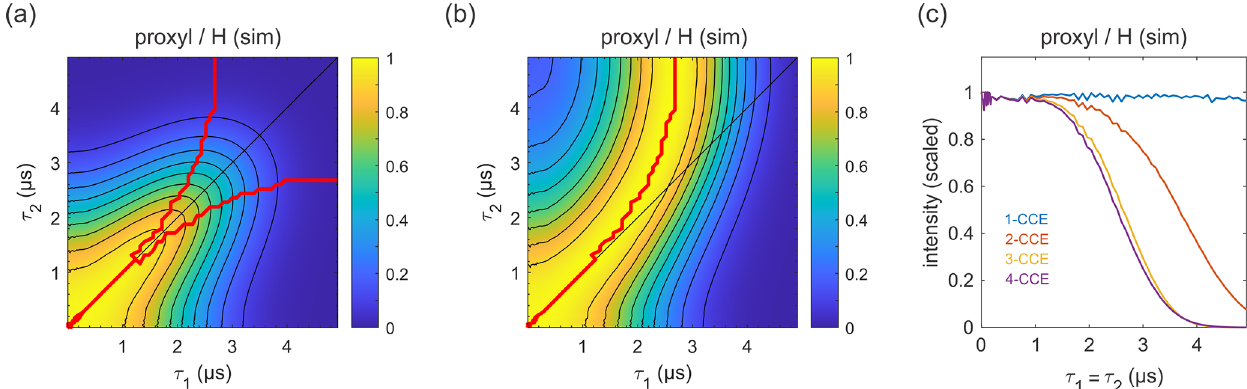
Figure 9. Simulation of the refocused echo decay for 3-maleimido-proxyl in H 2 O / glycerol (80 : 20 v/v ). Panel (a) shows the simulated refocused echo amplitude as a function of τ 1 and τ 2 , using 3-CCE. The τ 1 = τ 2 line is shown in black. The upper red curve in panel (a) indicates the ridge of panel (b) , which normalizes each slice along τ 1 (with constant τ 2 ) to unit maximal amplitude. The lower red curve in panel (a) is the analogous ridge for normalization along τ 2 . Panel (c) shows the simulated refocused echo decay for τ 1 = τ 2 as a function of cluster truncation level (1-CCE through